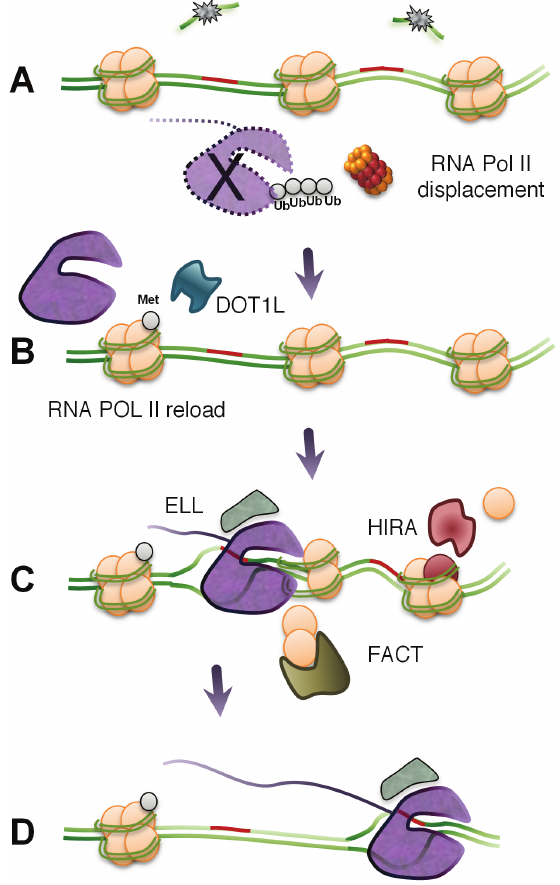
Figure 3. Transcription arrest leads to new beginnings. ( A ) As part of the DNA repair process, the RNA polymerase is displaced or degraded in a ubiquitin-dependent pathway. ( B ) Transcription starts anew from gene promoters. Specific histone modifications, including methylation of H3K79 by DOT1L, promote an open chromatin structure around promoters and control speed of transcription elongation. ( C ) Elongation factor ELL may serve as a docking site and contribute to transcriptional restart after repair. HIRA proteins